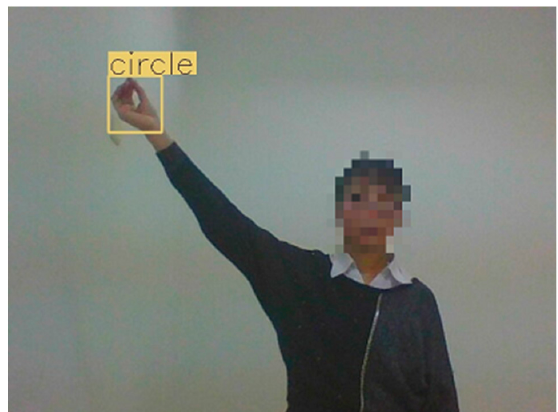
Figure 13. Result of recognition of hand postures in the lab.